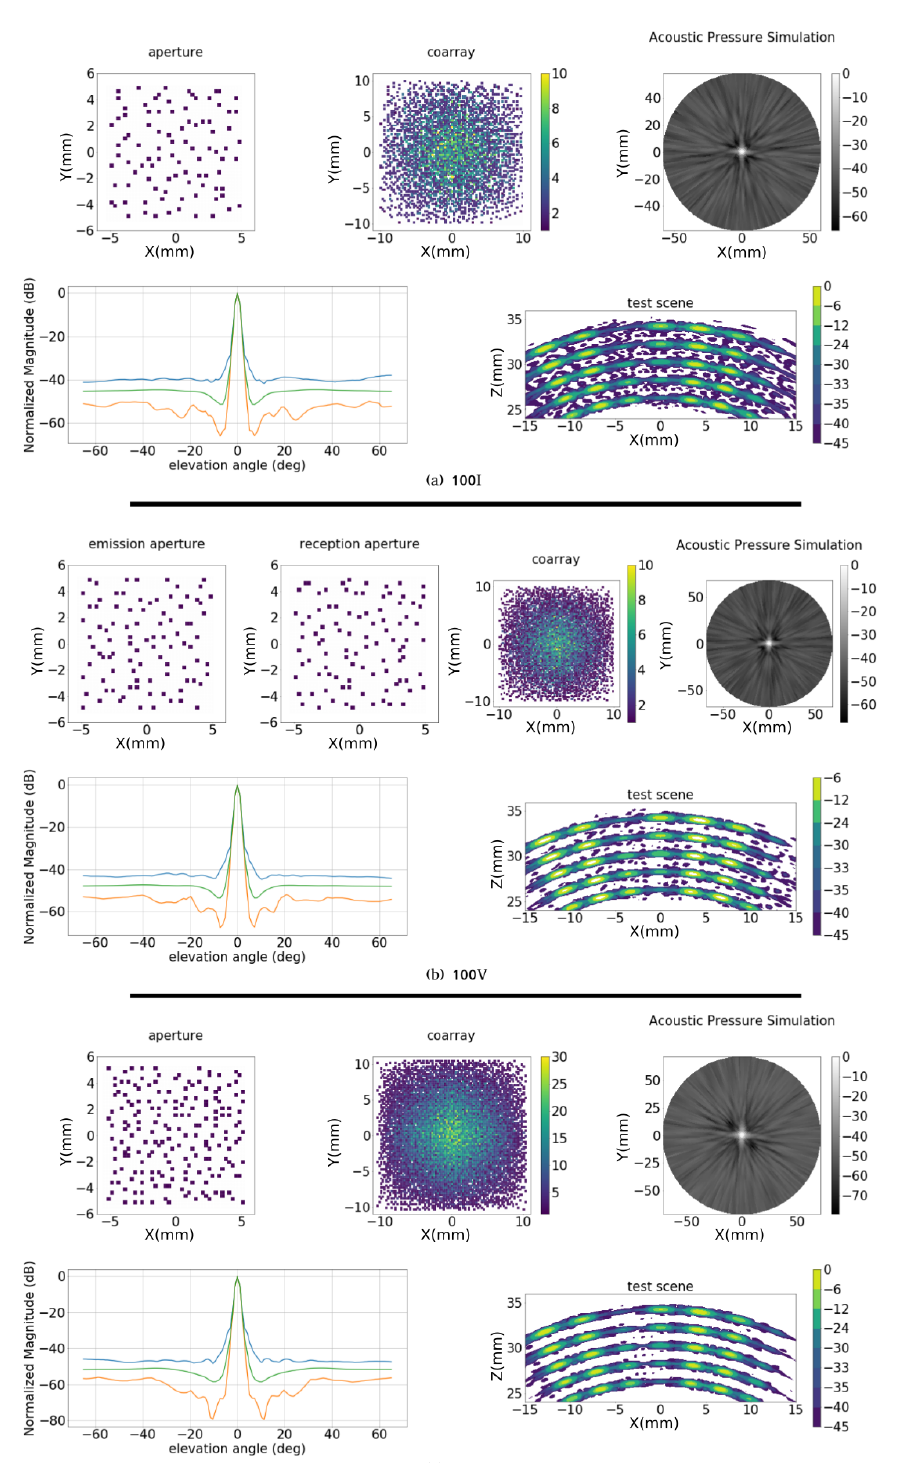
Figure 12. Optimization with combined fitness function. Best results for configurations ( a ) 100I, ( b ) 100V and ( c ) 196I. In each figure are presented: emission (and reception for 100V) apertures; coarray matrix representation; acoustic field in the semi-sphere; and, maximum (blue), mean (green) and minimum (red) lateral profile at each elevation angle; and image resulting from the test